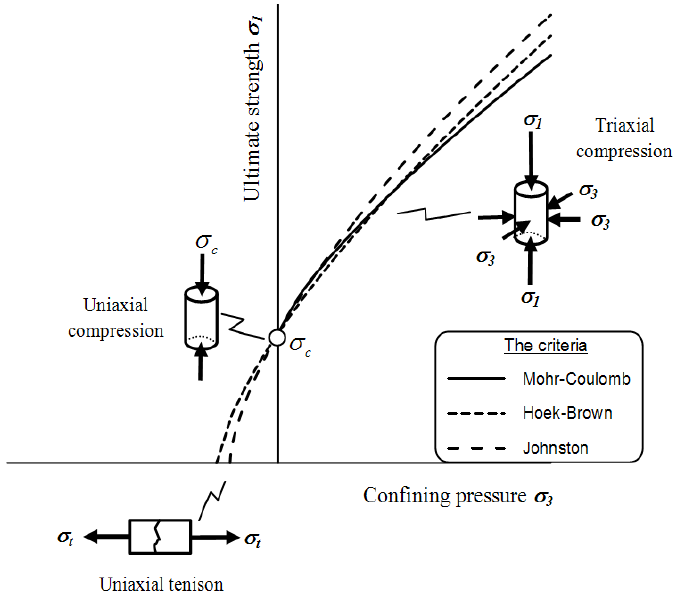
Figure 1. Mohr-Coulomb, Johnston and Hoek-Brown’s failure envelope to estimate the ultimate strength under triaxial